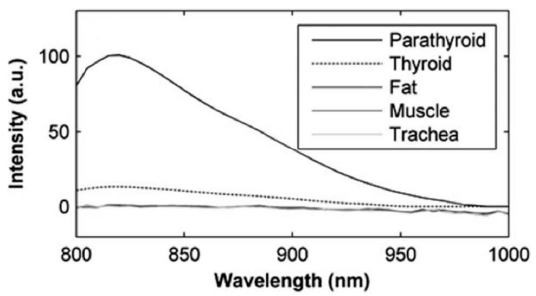
Figure 1. Comparison of the autofluorescence intensities of different tissues (note that the traces for fat, muscle, and trachea are not discernable because they are superimposed) [15].